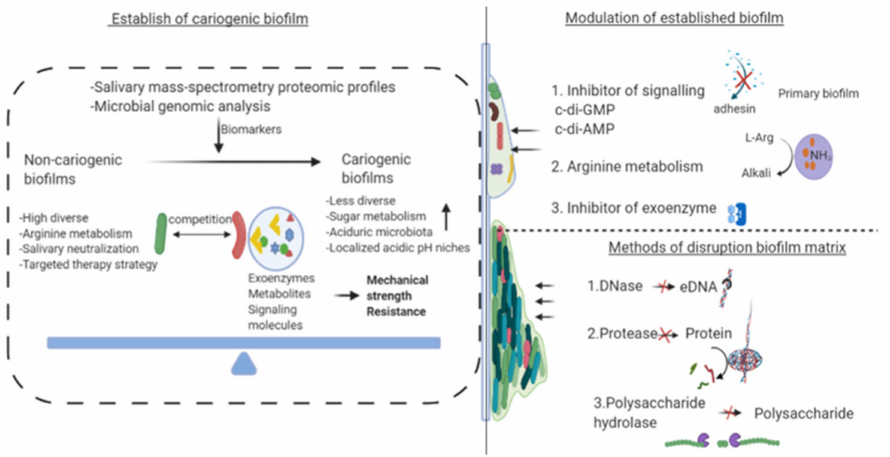
Figure 2. Establishment of cariogenic biofilm and therapeutic strategies targeting the cariogenic biofilm. Competition between oral resident microorganisms and opportunistic pathogens will shift the dynamic balance of dental biofilm microflora. In the cariogenic biofilm, microbial diversity decreases as an aciduric microbiota predominates. The effective therapies to control cariogenic biofilms include the modulation of biofilm microbiota and the disruption of the biofilm matrix. The illustration was created with BioRender.